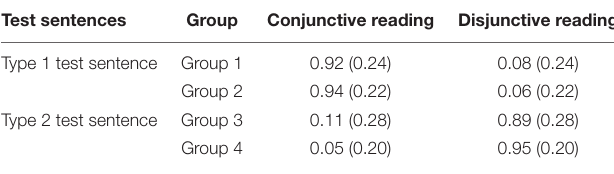
TABLE 1 | Percentage of judgments of participants in Experiment